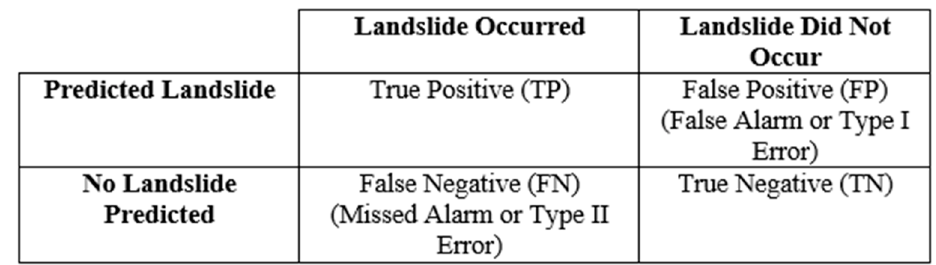
Figure 1. Confusion matrix describing the relationship between the occurrence of landslides and the prediction of landslides.